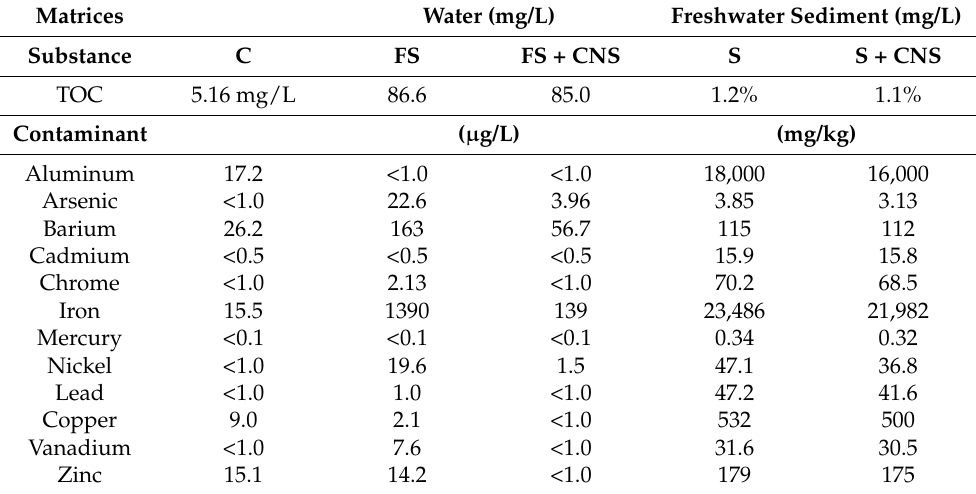
Table 1. Concentration of metals in exposure waters and sediments. Water samples: control group (C), outflowing water obtained by sludge filtration (FS), and outflowing water obtained by sludge enriched in CNS filtered by fine-mesh net (FS + CNS). Sediment samples: sediment trapped in the net (S) and sediment enriched in CNS trapped in the net (S + CNS).